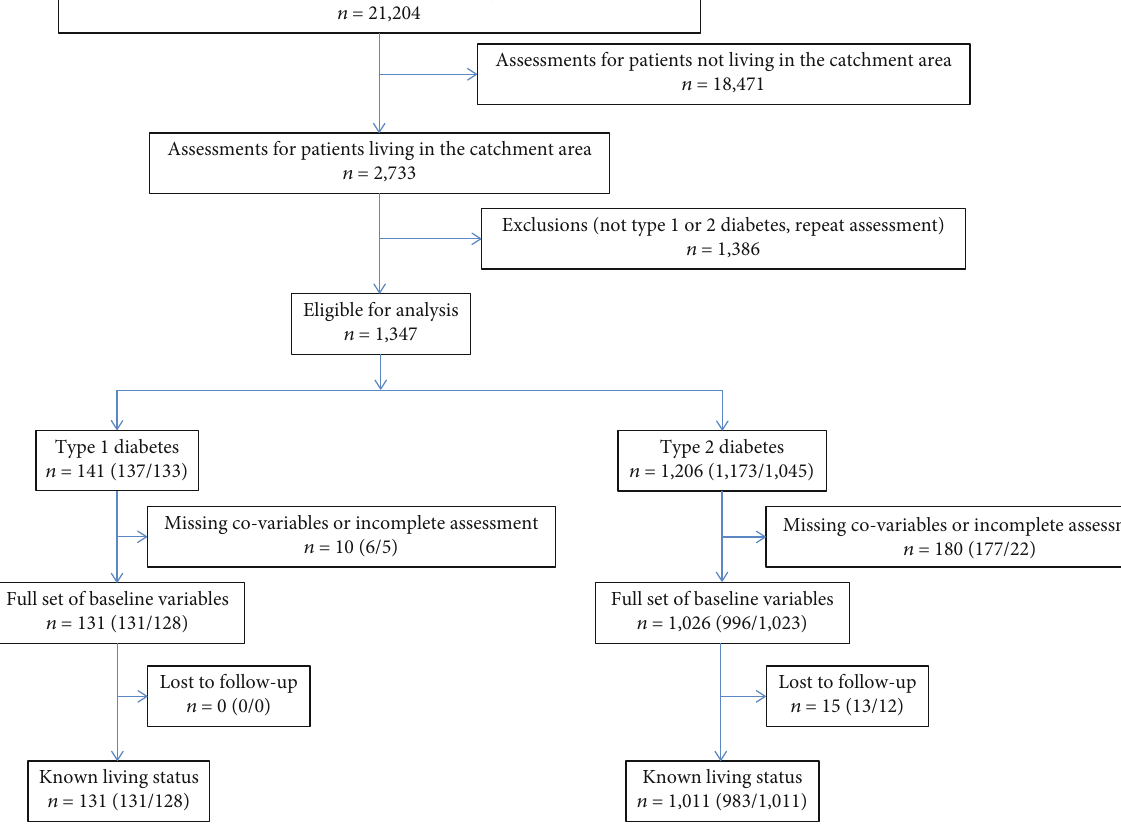
Figure 1: Flow chart of the selection of participants for the current study. Numbers are given for people with any neuropathy. Numbers in brackets are given for people with distal symmetric polyneuropathy/cardiovascular autonomic